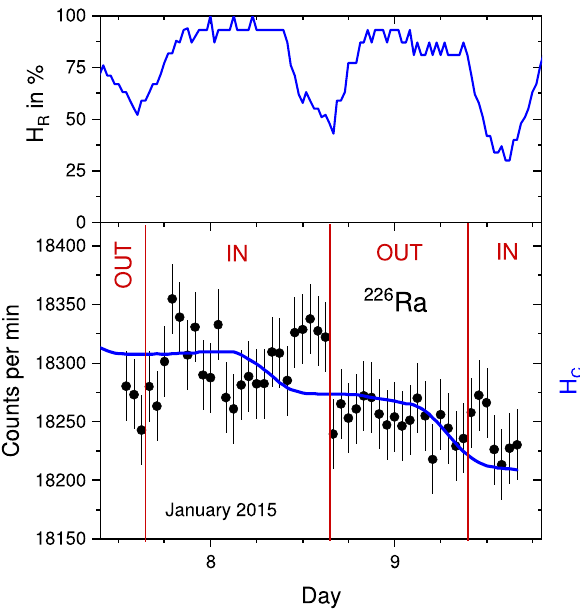
Fig. 8 Relative humidity in the Valencia region (top) in the period 7– 9 Jan 2015 [68]. Qualitative comparison (bottom) of measured 226 Ra decay rates [27,29] with the accumulated-humidity model H C ( t ; ¯ H R = 92% ,(cid:3) t = − 7h ) in Eq. 1. The indicators IN and OUT refer to the position of the detector inside or outside of the